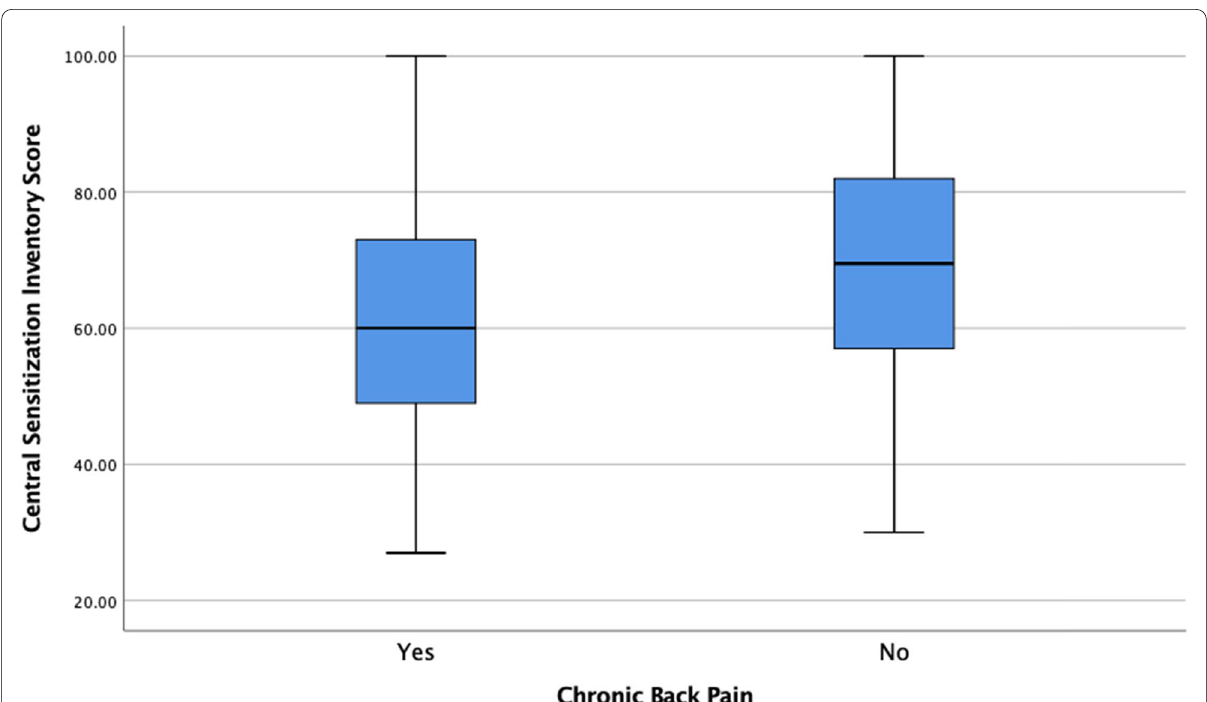
Fig. 1 Comparison of mean scores using independent sample t test of central sensitization inventory among students with and without chronic back pain